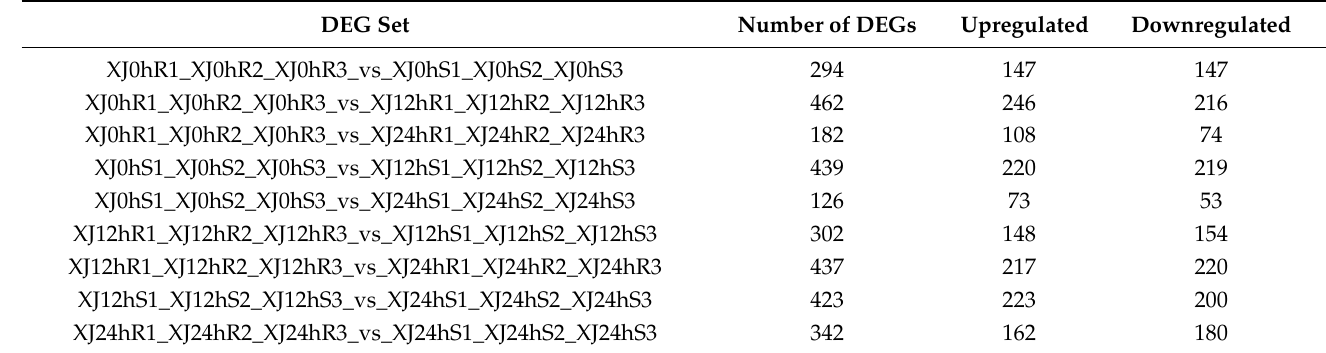
Table 3. Statistics for the number of lncRNAs that were found to be differently